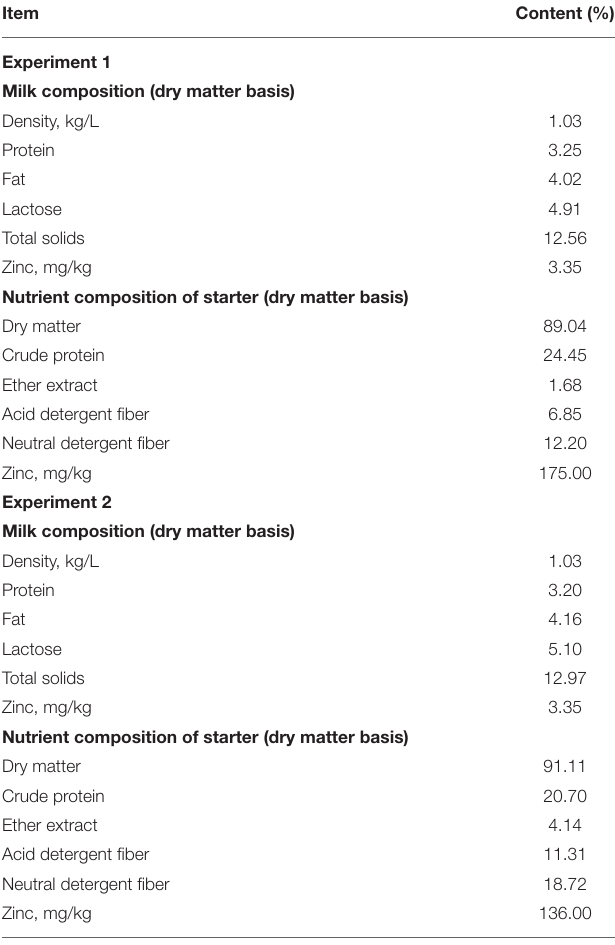
TABLE 1 | Nutrient compositions of the milk and starter diet (%, unless noted) 1